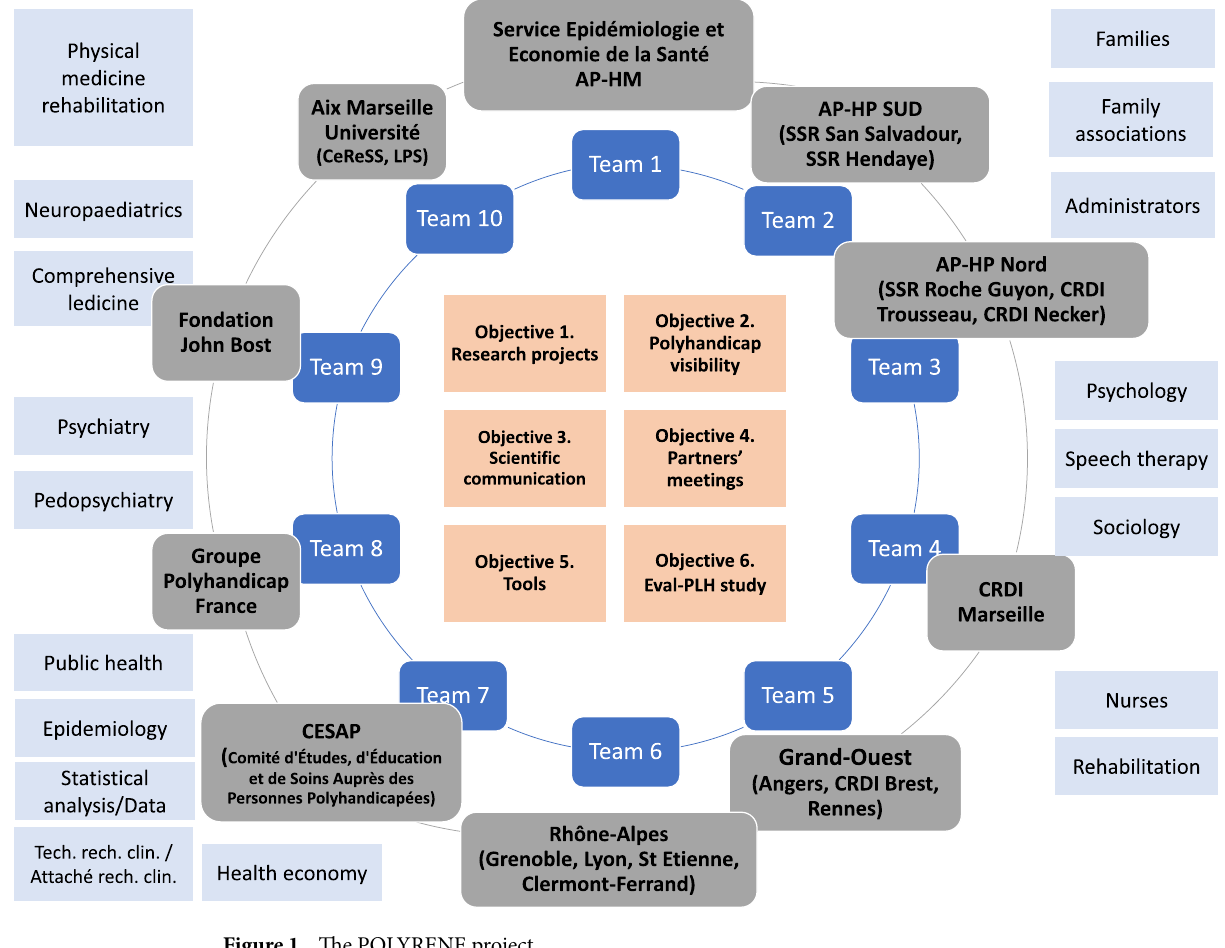
Figure 1. The POLYRENE